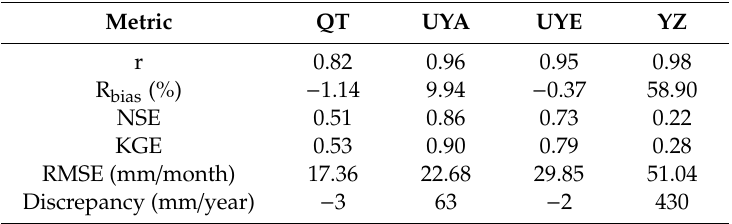
means, and dispersion of two paired